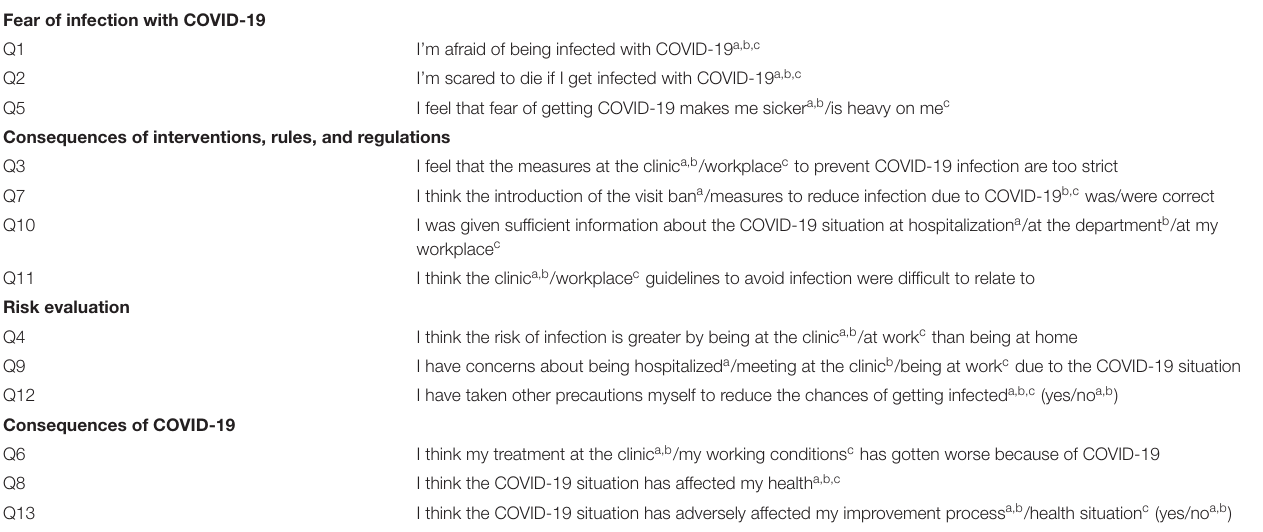
TABLE 1 | Statements in the questionnaires (Q1–Q13). Fear of infection with